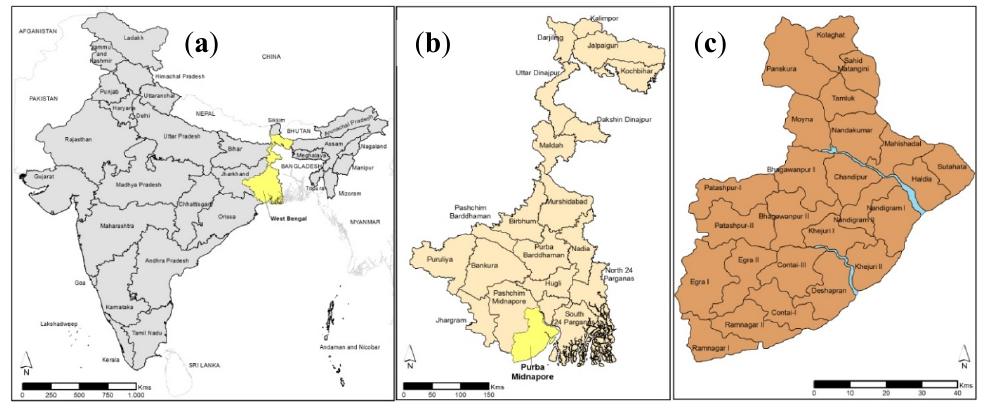
Figure 1. Geographic location map of the study area. ( a ) Map of India showing different states. The state of West Bengal is highlighted in yellow. ( b ) Map of West Bengal showing different districts within the study area; Purba Medinipur district is marked in yellow. ( c ) Map of study area; Purba Medinipur district (block wise).